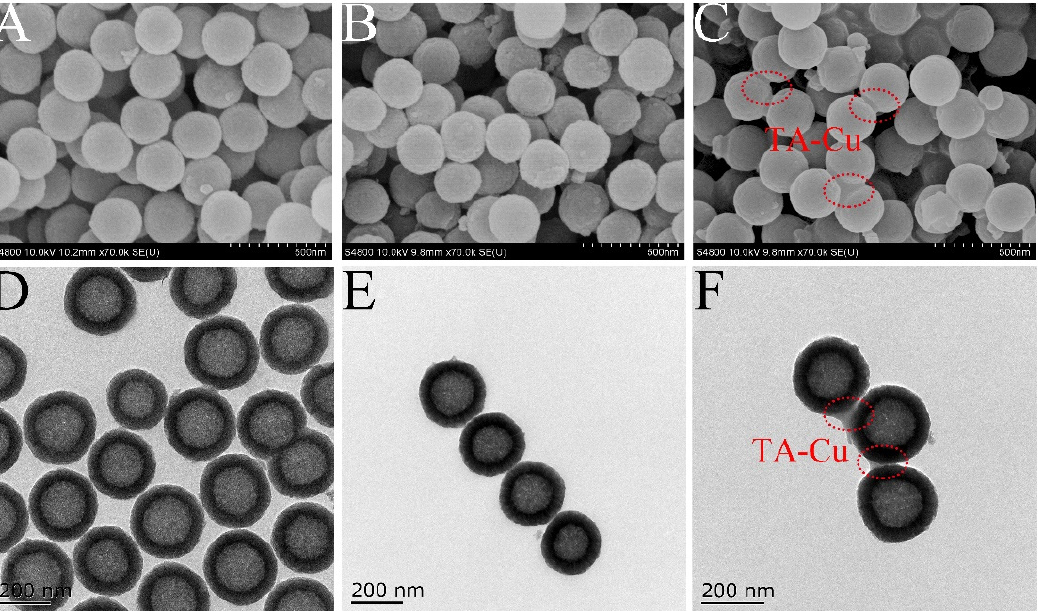
Figure 1. SEM images of HMS ( A ), HMS-NH 2 ( B ) and HMS-TA-Cu ( C ); TEM images of HMS ( D ), HMS-NH 2 ( E ) and HMS-TA-Cu ( F ). Table 1. N 2 sorption analysis of HMS, HMS-NH 2 and HMS-TA-Cu. Experiment Ma-